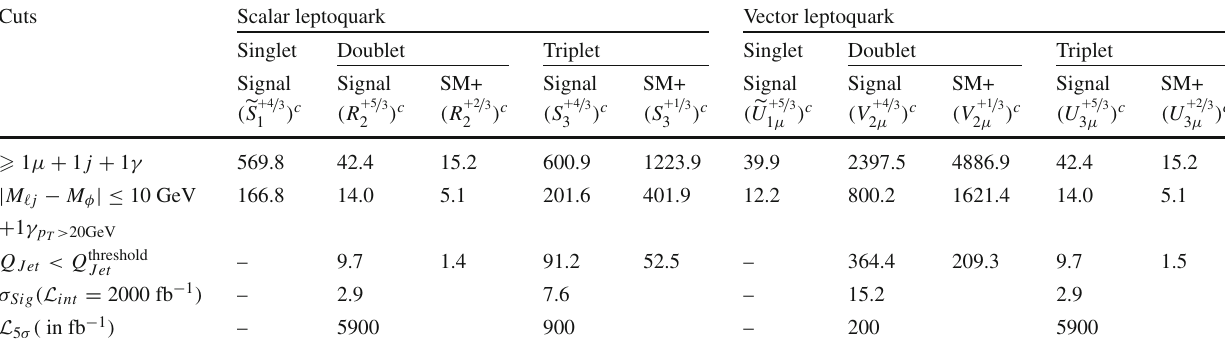
has been chosen 0 for R c Jet